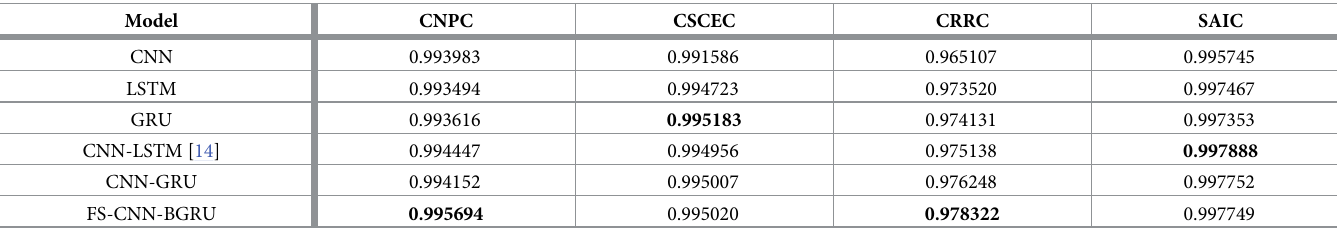
Table 14. R 2 of common